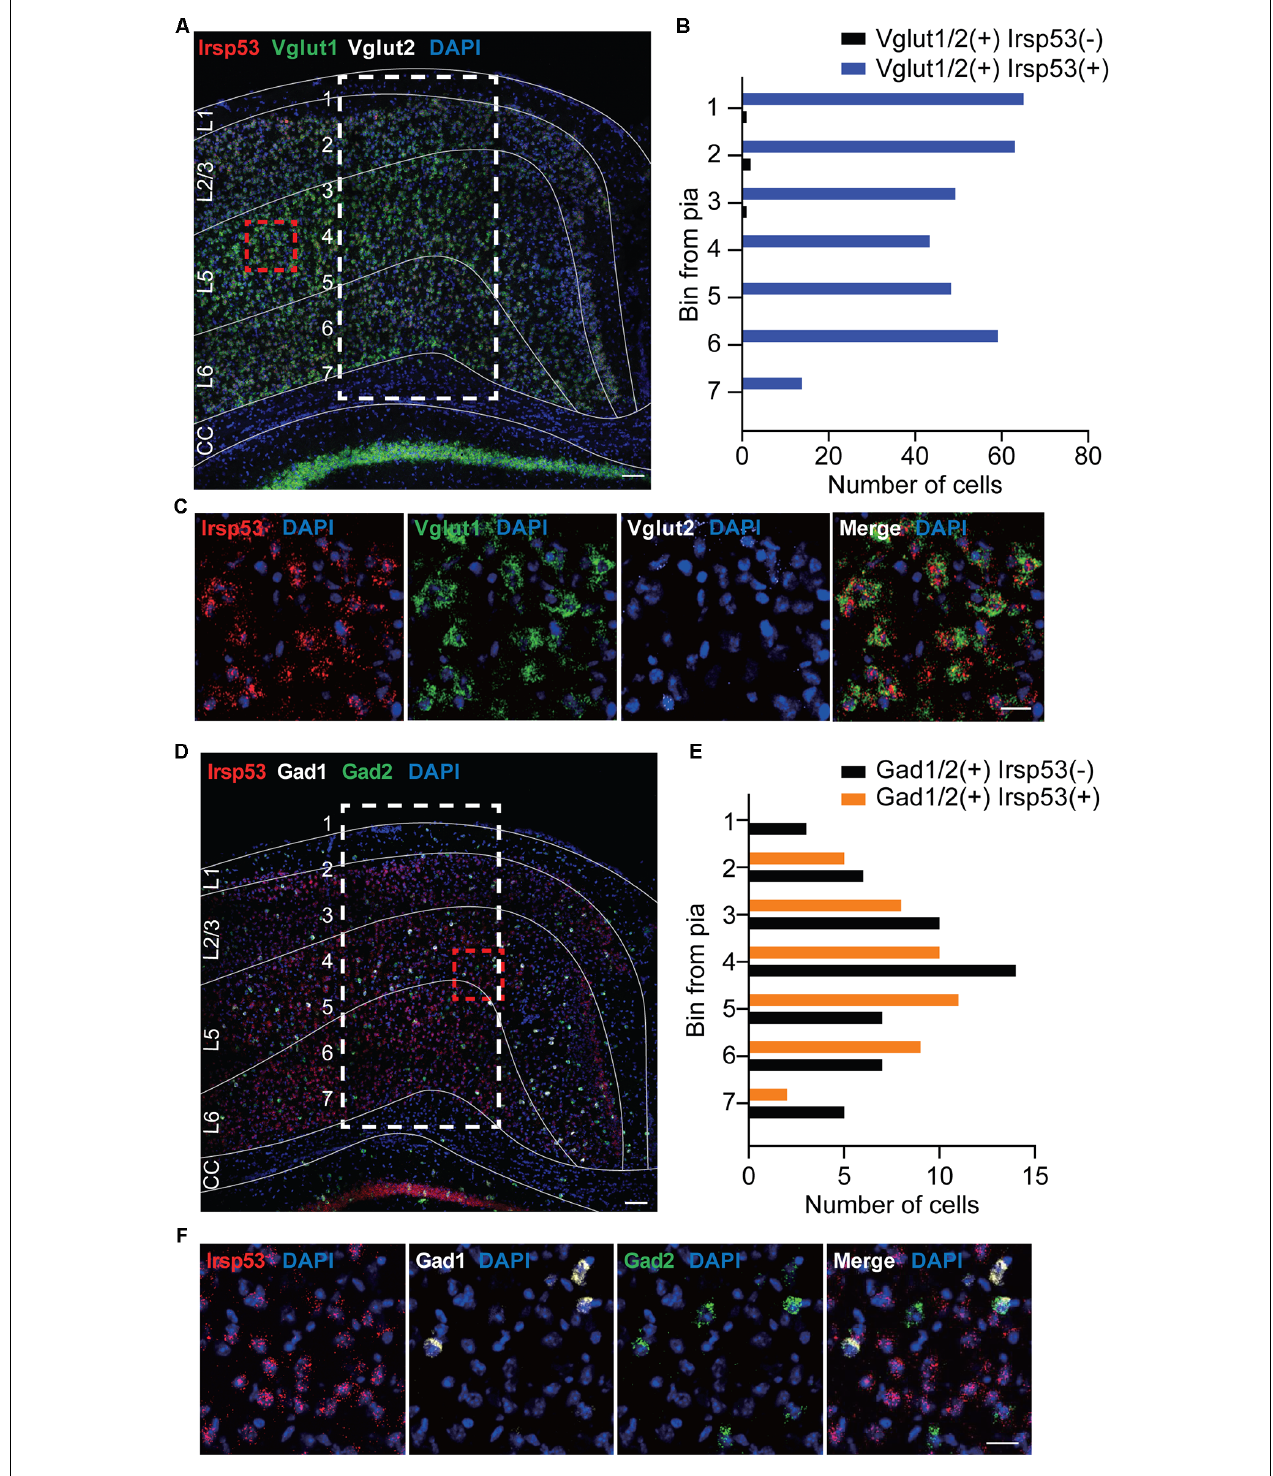
FIGURE 1 | Irsp53 mRNAs are primarily detected in glutamatergic but minimally in GABAergic neurons in the cortex. (A–F) Coronal sections of WT mice (8 weeks) were subjected to fluorescence in situ hybridization. Note that Irsp53 / Baiap2 mRNAs are detected in Vglut1/2 -positive glutamatergic neurons but minimally in Gad1/2 -positive GABAergic neurons in the motor and somatosensory cortex. DAPI was used for nuclear staining. Red dashed line boxes were enlarged to show the levels of neuronal colabelings, and white dashed line boxes with subdivisions across cortical depth were used to quantify the colabelings. L1, cortical layer 1; CC, corpus callosum. Scale bar, 100 µ m (A,D) and 25 µ m (C,F) .